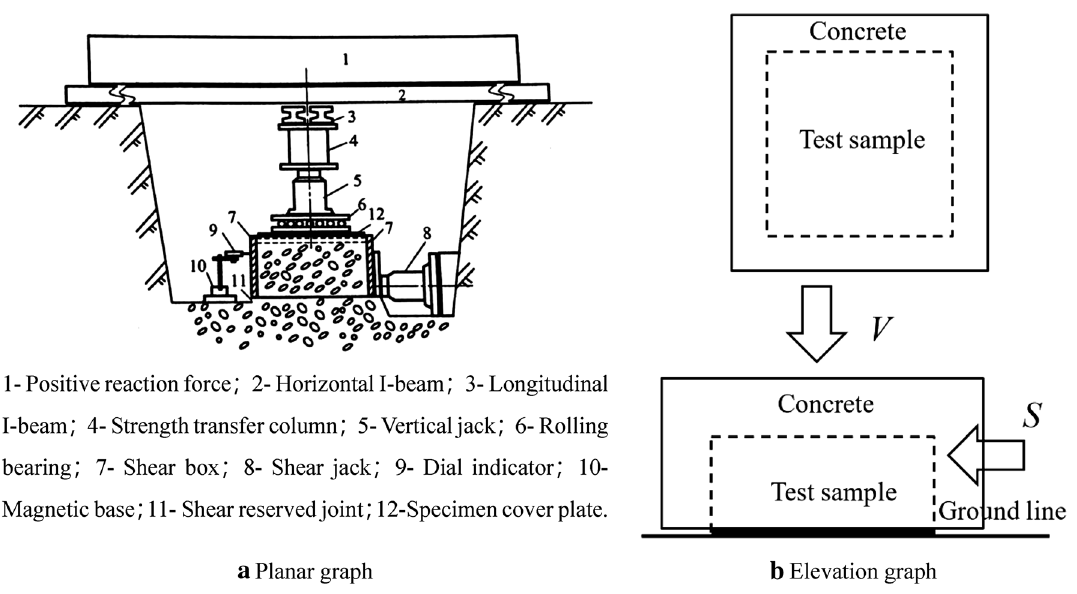
Figure 4. Device of in-situ shear